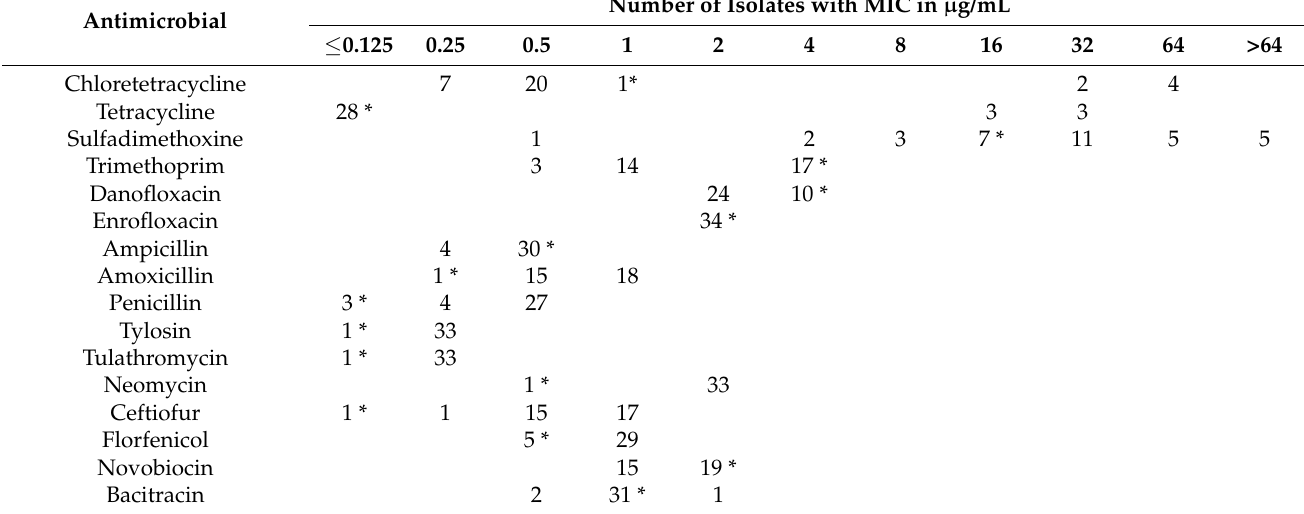
Table 1. MIC result distributions of 16 antimicrobials against 34 isolates of D. congolensis . Results of the D. congolensis ATCC 14637 reference strain are indicated with an asterisk (*). Blank table cells indicate that none of the isolates had MIC values corresponding to the given concentration. Number of Isolates with MIC in µ Antimicrobial